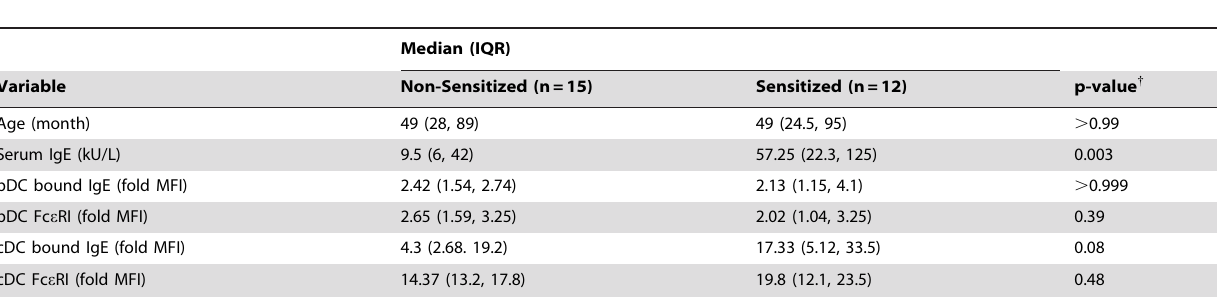
Table 2. Comparison of Sensitized and Non-Sensitized Children for Dendritic Cell Expression of IgE and Fc e RI.